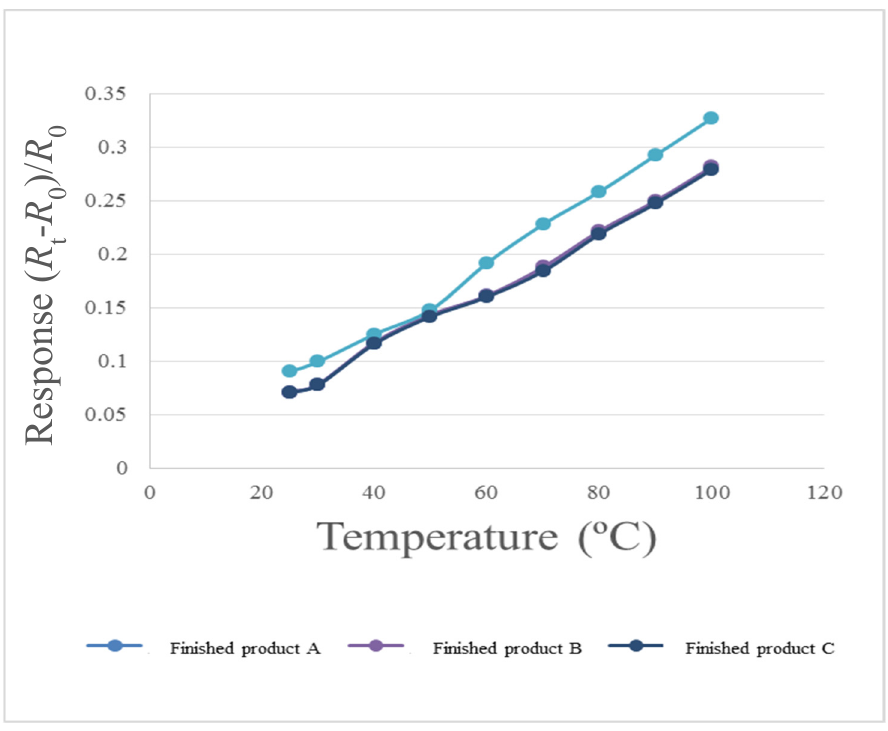
Figure 9. Correction curve of micro temperature sensor.